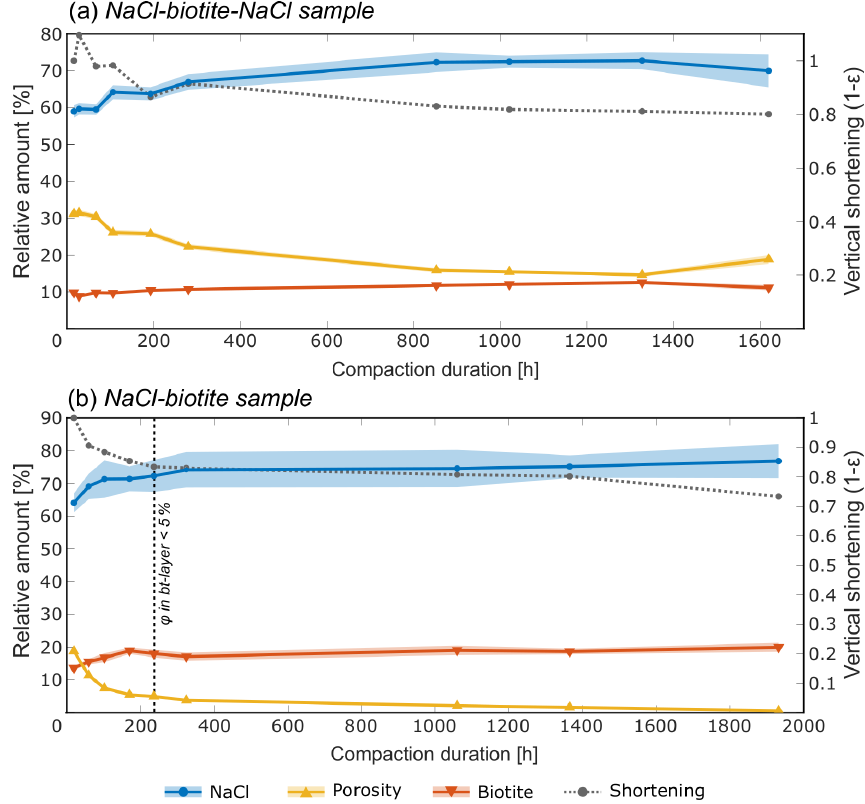
Figure 15. Evolution of the relative volumes of NaCl, biotite and porosity in the biotite-bearing layers of (a) the SBS and (b) the SB sample, with progressing deformation. In both samples, the biotite content remains constant within the segmentation error (plotted as shade in the respective colour), while the NaCl content increases and the porosity decreases. This is persistent throughout the experiment. After 324h of compaction, the increase of the NaCl content in the SB sample (b) stagnates, which corresponds to the breakdown of porosity in the biotite-bearing